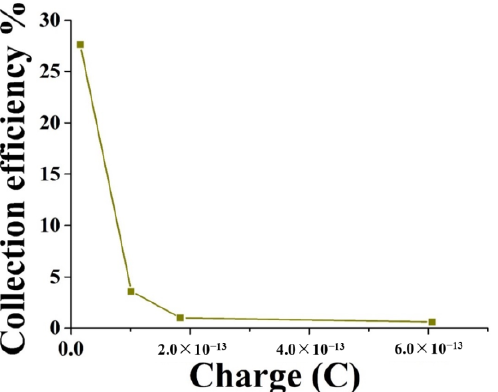
Figure 10. Variations in particle collection efficiency with droplet charge number. Operating condi- tions: N 2 flow rate is 4 L/min, nozzle voltage is 7000 V, ring voltage is 500 V.